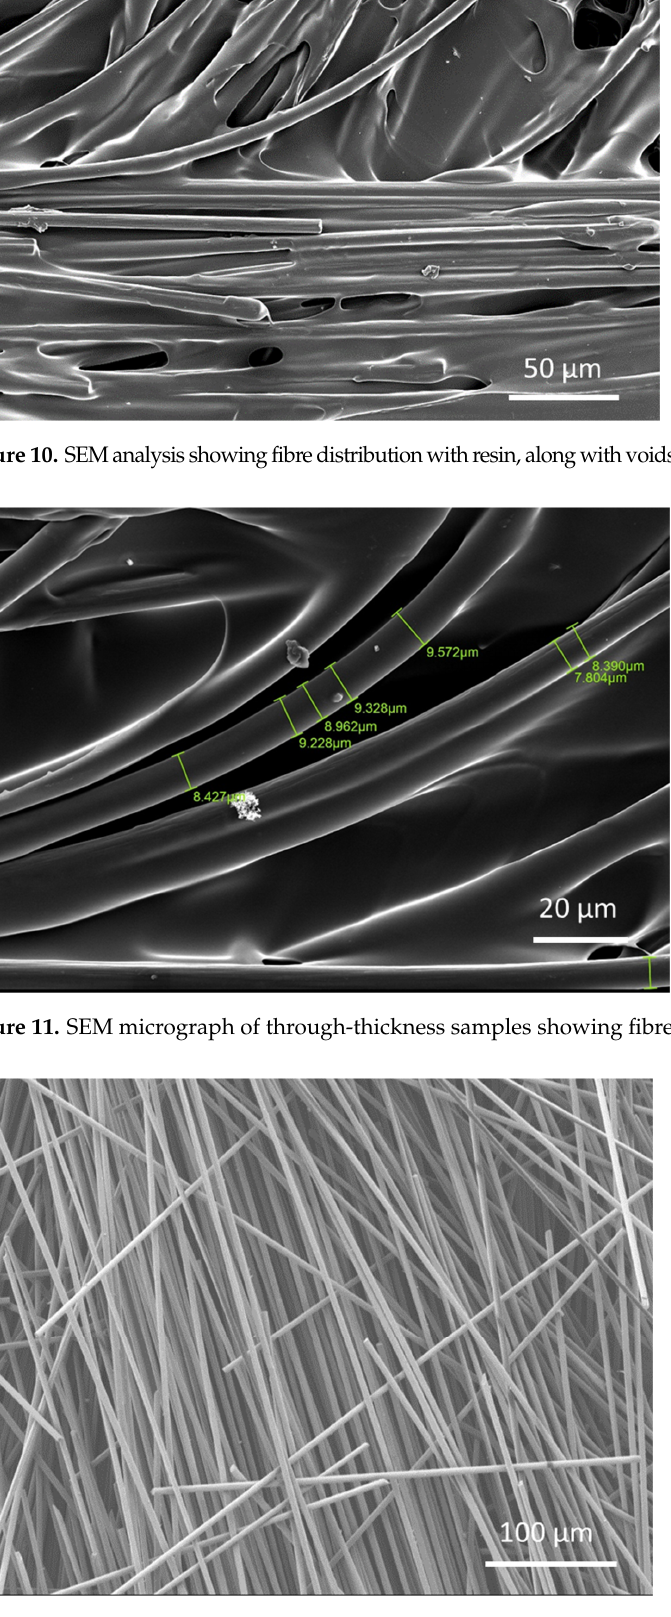
Figure 12. SEM image of the fibres obtained through thermogravimetric